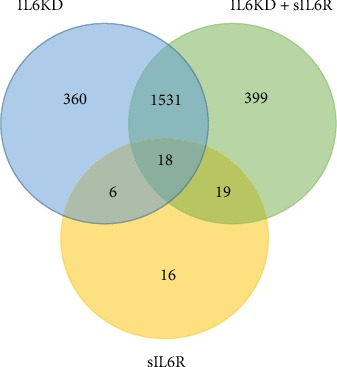
Number of differentially expressed genes in human endothelial cells after IL6 knockdown. The number in each circle represents the number of differentially expressed genes using a fold change of 1.5 and Benjamini-Hochberg's estimate of the false discovery rate below 0.05. The numbers within intersections stand for mutual differentially expressed genes between the different conditions, and numbers outside intersections represent genes unique to each condition. IL6KD: IL6 knockdown vs. control (blue circle). IL6KD+sIL6R: IL6 knockdown in the presence of the soluble IL6 receptor vs. soluble IL6 receptor (green circle). sIL6R: soluble IL6 receptor vs. control (yellow circle).